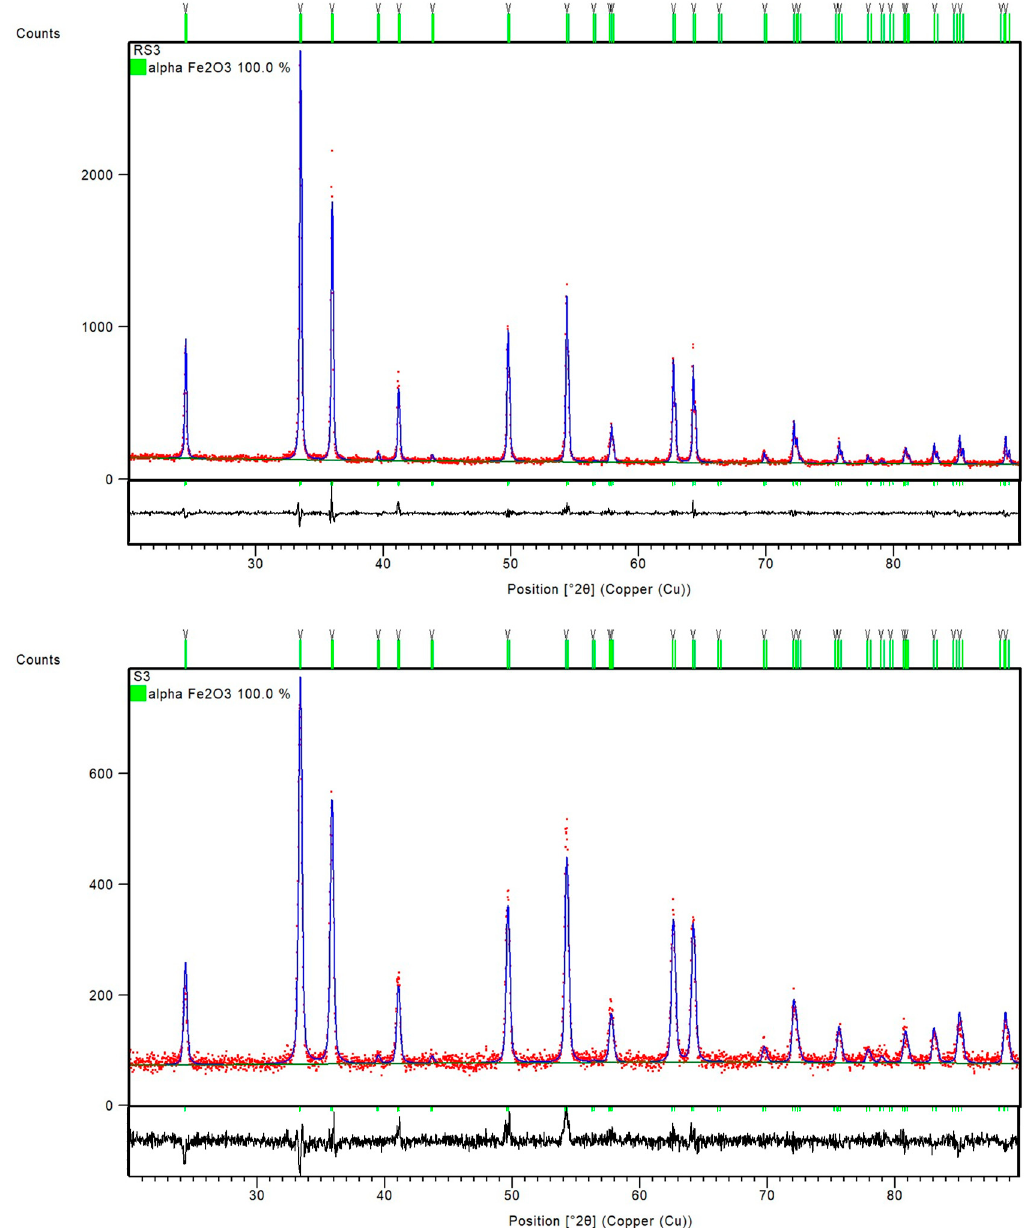
Figure 4. Final observed (red dots) and calculated (blue, solid lines) powder diffraction profiles for reference sample RS3 and sample S3 as obtained from the Rietveld refinement. The green and gray tick marks show the reflection positions of α -Fe 2 O 3 and α -FeOOH, respectively. The lower, black, solid lines show the difference profiles.